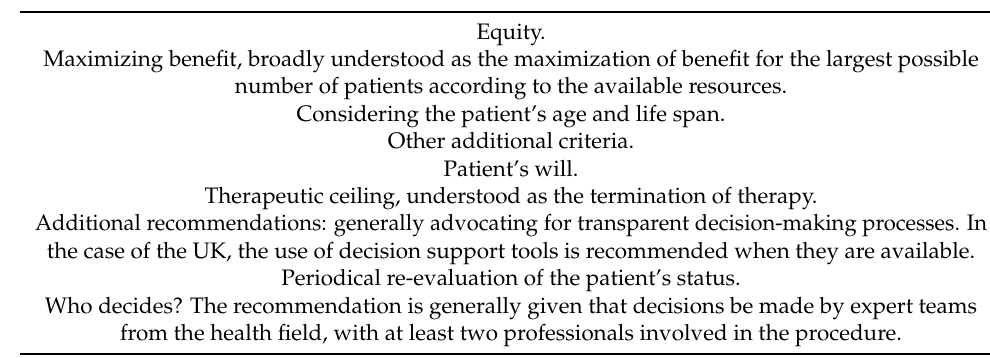
Table 1. Main criteria considered for the assessment of patients’ status in sanitary collapse situations. Elaborated from the work by Joebges and Biller-Andorno [1].